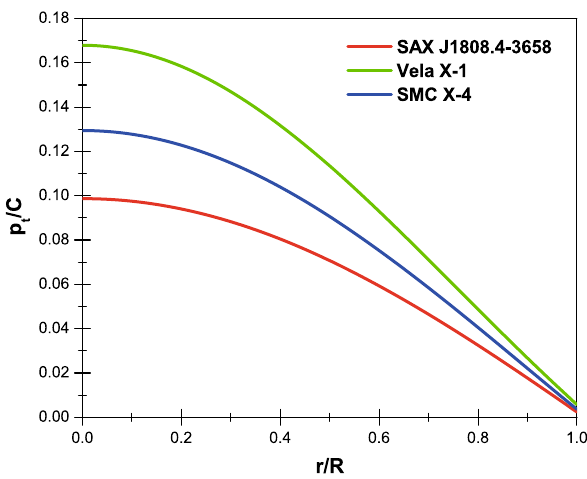
Fig. 6 The dimensionless tangential pressure against the fractional radius for α = 0 . 3